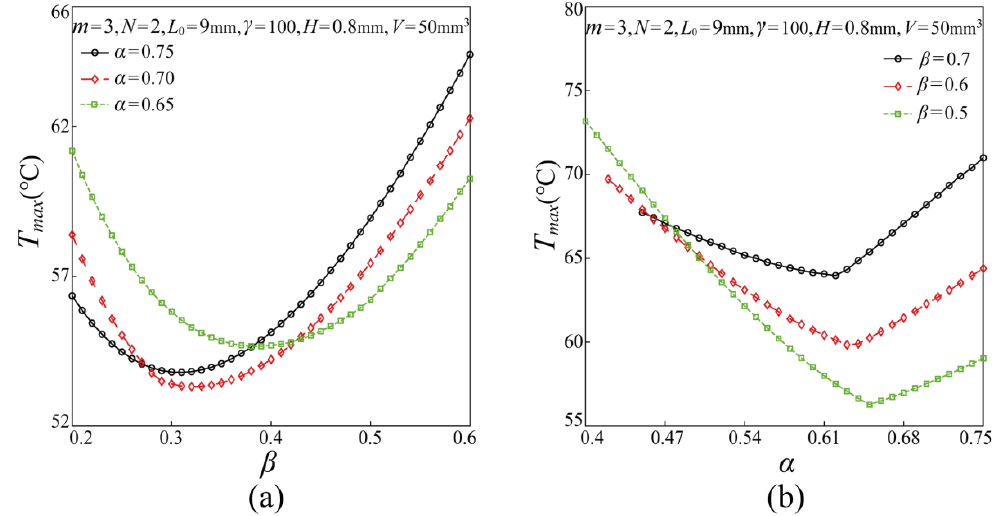
Figure 3. ( a ) Effect of β on the maximum temperature of the chip with different value of α ( b ) Effect of α on the maximum temperature of the chip with different value of β .